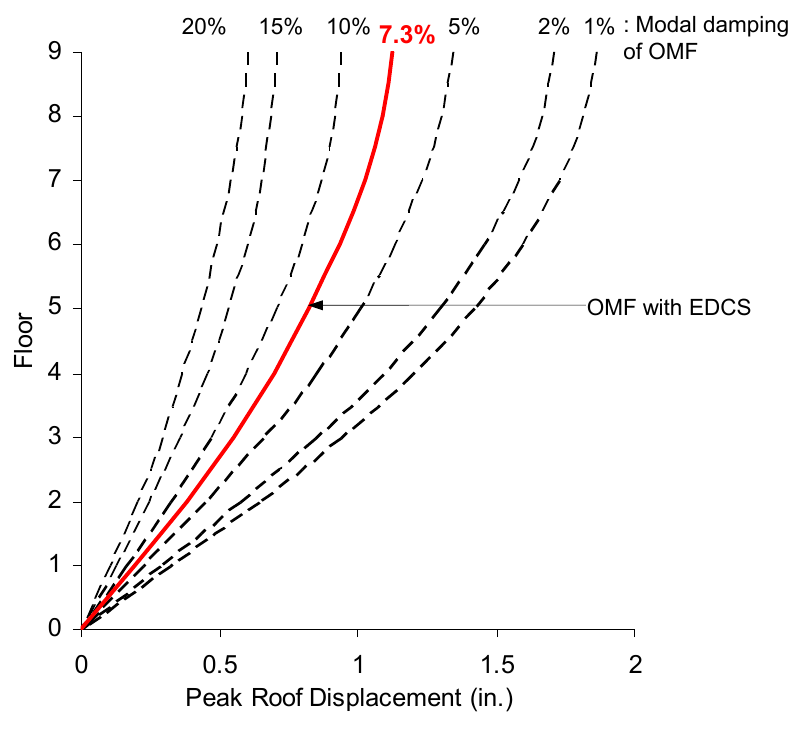
Figure 7. Equivalent modal damping of supplement